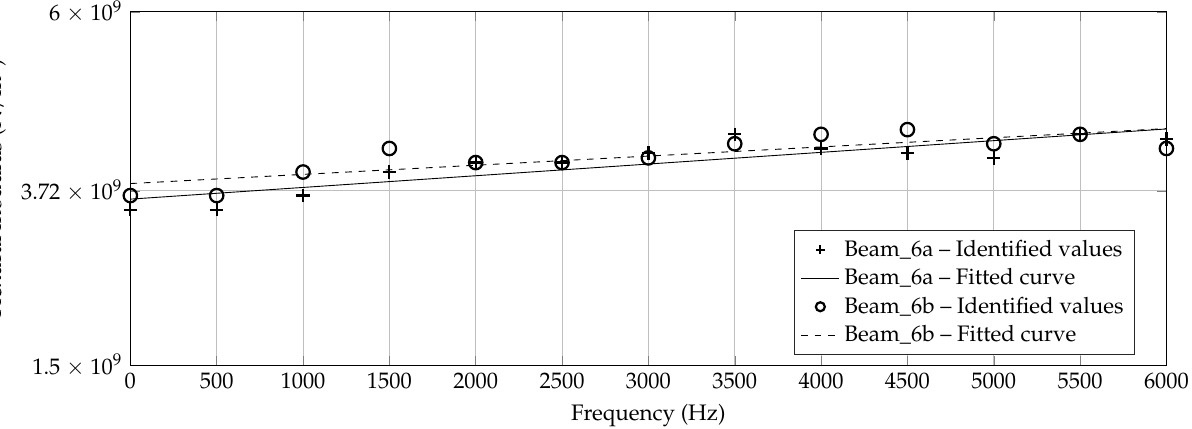
Figure 13. Identified flexural moduli by Figure 12 for Beam_6a/b with fitted linear